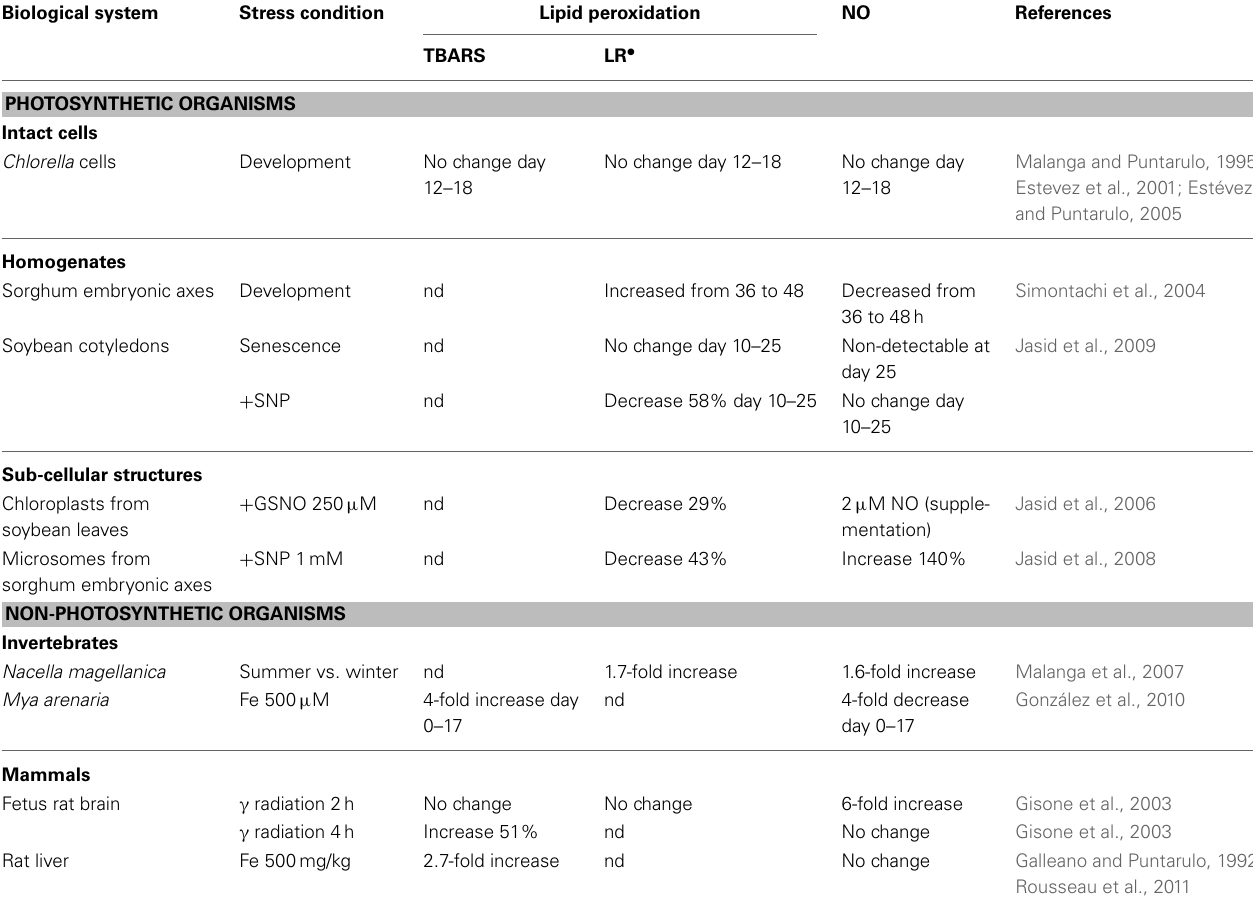
Table 1 | Nitric oxide and lipid peroxidation under stress conditions in photosynthetic and non-photosynthetic